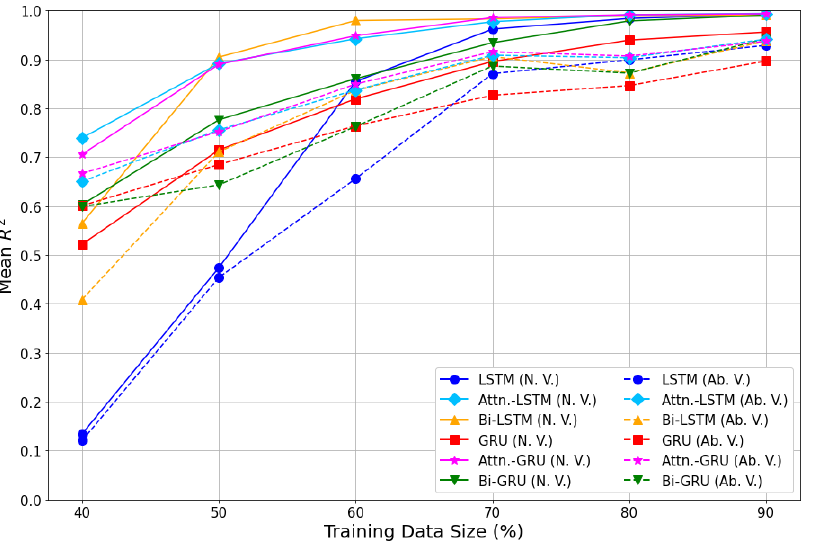
Figure 13. Average value of the coefficient of determination according to the size of the training data.